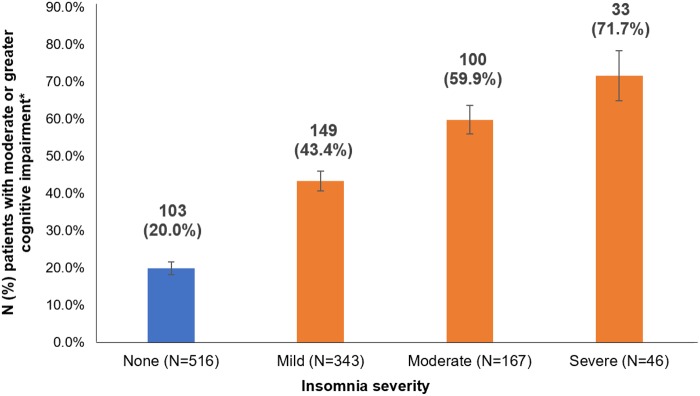
Prevalence of moderate or greater perceived cognitive impairment among breast cancer survivors by severity of comorbid insomnia.*Score ≥2 on at least one of the Breast Cancer Prevention Trial cognitive items (ie, forgetfulness, concentration, distractibility) indicates moderate or greater perceived cognitive impairment.